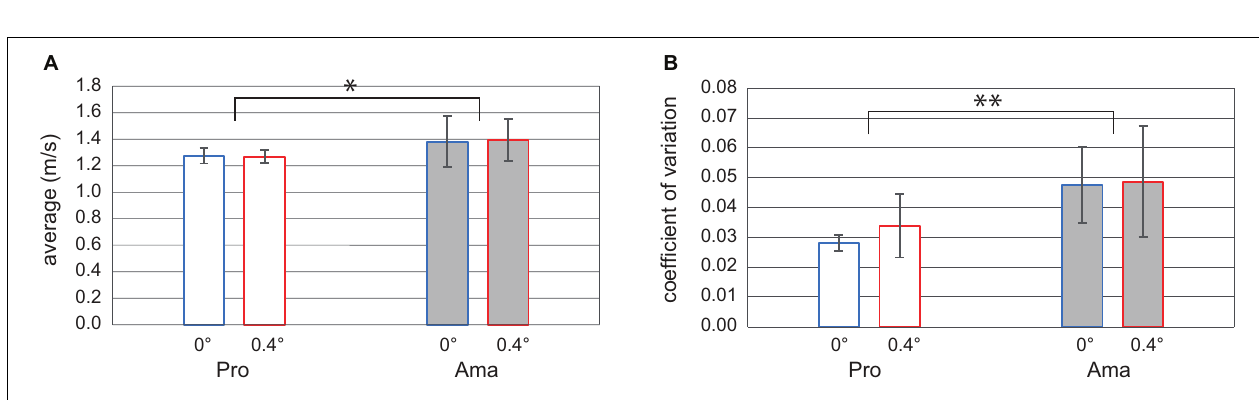
FIGURE 7 | Averages of impact velocity and impact velocity CV. (A) Consists of the average values of the impact velocity for each group. (B) Composed of the average values of the variation coefficient in each group. The error bars indicate ± 1SD. * p < 0.05 and ** p <